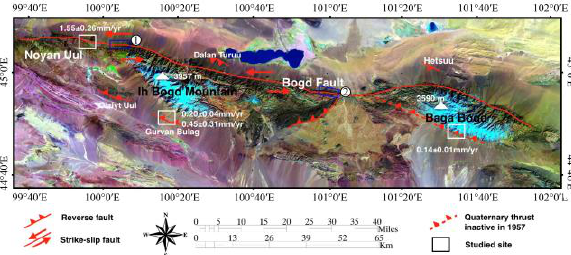
Figure 3. This false colour image uses Landsat ETM+ 7 (shortwave infrared) for red, band 4 (near infrared) for green, and band 1 (blue) for blue. Simplified tectonic map of Gobi- Altai fault (modified after Vassallo et al., 2007). Based on Landsat ETM+ 7 data provided by the NASA Landsat Program, 2000. The two blue boxes are typical sites shows in Figure 4.